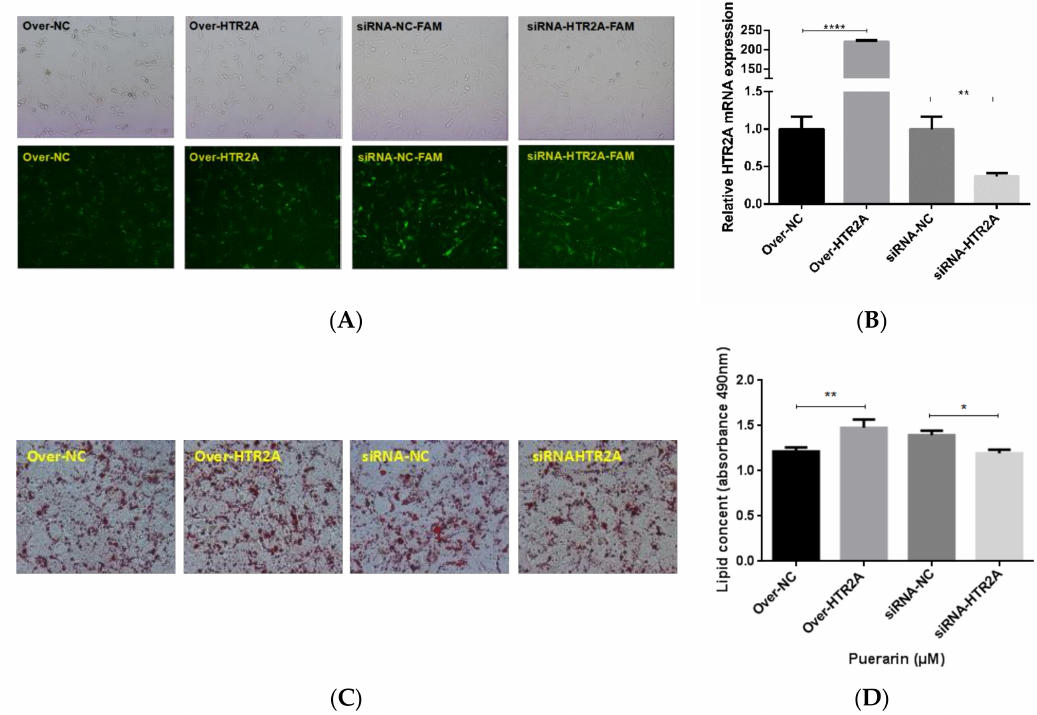
Figure 6. The role of HTR2A in the regulation of adipogenesis. ( A ): detection of transfection efficiency of HTR2A overexpression and knockdown (200 × ); ( B ): the expression level of HTR2A after HTR2A overexpression and knockdown; ( C ): oil Red O staining of induced differentiated adipocytes (200 × ); ( D ): the detection of lipid droplets of induced differentiated adipocytes. The panels in all of the figures were overexpression negative control, overexpression, knockdown negative control, and knockdown group from left to right. Values are means ± SD. vs. control group, * p < 0.05; ** p < 0.01; **** p <